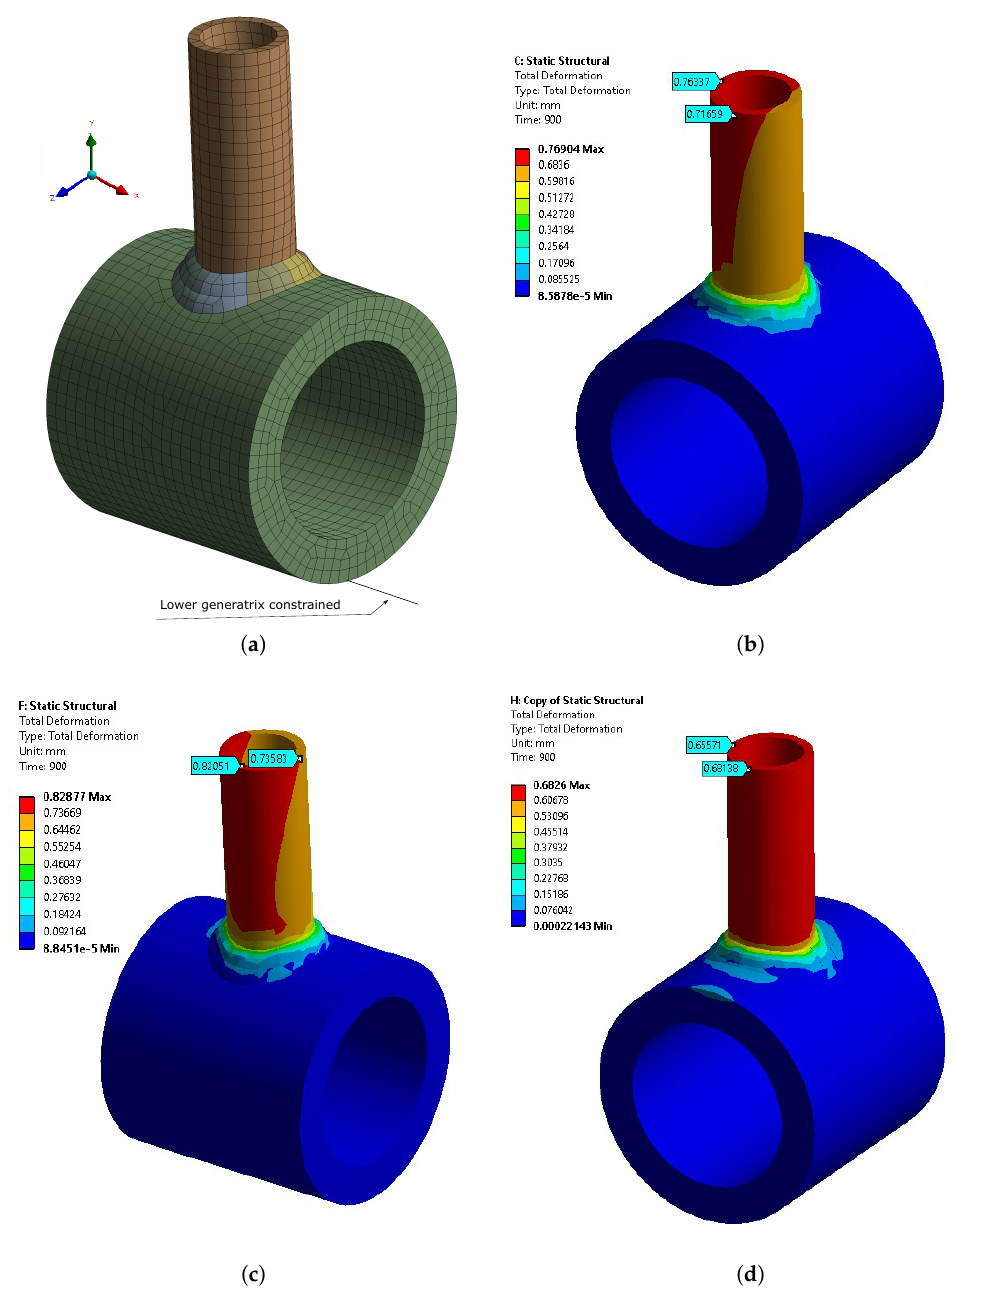
Figure 12. ( a ) Finite Element model and boundary conditions and predicted distortion contours at steady state for Sequences 1 ( b ), 2 ( c ), and 3 ( d ) in the Vetriselvan